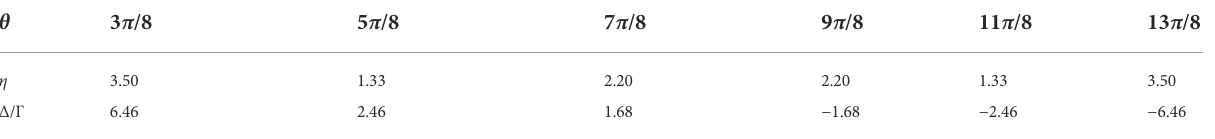
TABLE 1 The values of the parameters θ , η and Δ at extremum points with T n = R n = 0.5 and T m = R m = 0 in Figures 5, 6. θ 3 π /8 5 π